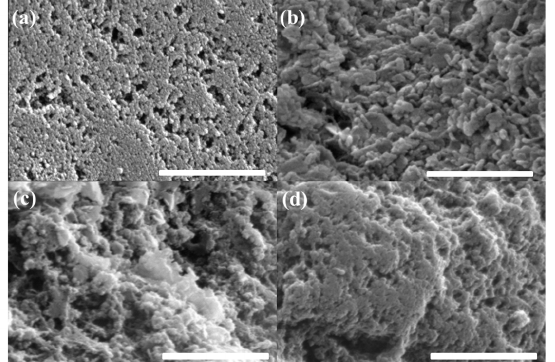
Figure 1. SEM images of ( a ) bare AC, ( b ) 1-MgO-AC, ( c ) 2-MgO-AC, and ( d ) 5-MgO-AC (scale bar: 500